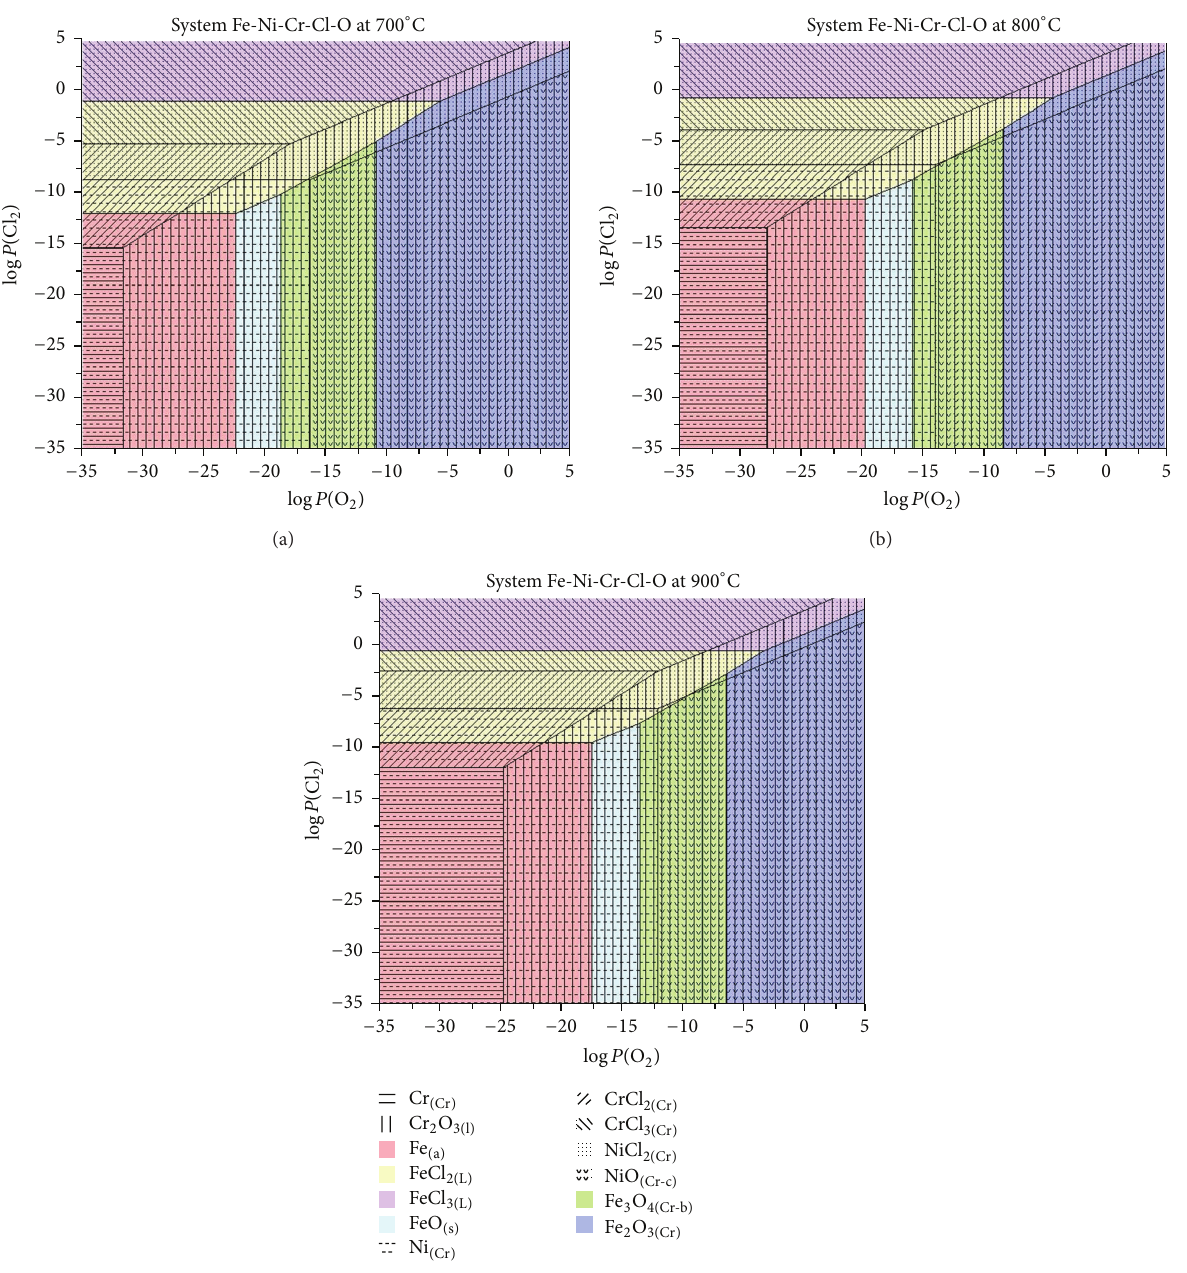
Figure 8: Thermodynamic stability diagrams for Fe-Cr-Ni-Cl-O at (a) 700 ∘ C, (b) 800 ∘ C, and (c) 900 ∘